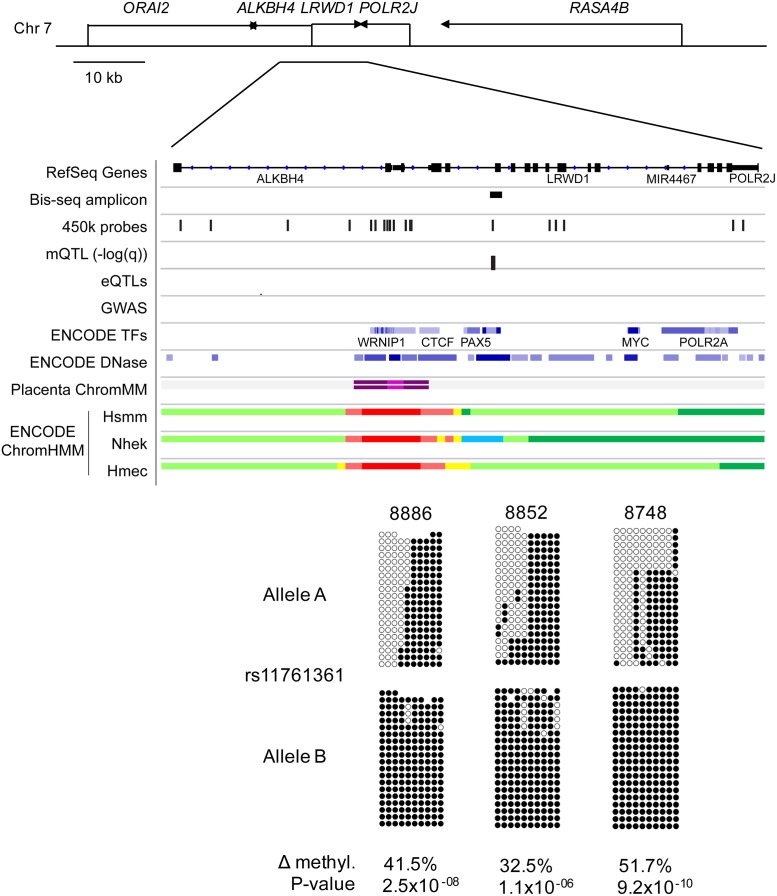
mQTL validation.Targeted bis-seq data showing Hap-ASM in LRWD1 region. The bis-seq amplicon covers 289 bp including the mQTL index CpG queried in Illumina 450K BeadChips arrays (cg25932869), as well as contiguous CpGs. Graphical representation from 3 representative heterozygous placenta samples with hap-ASM is shown. This region overlaps with the common SNP, rs11761361. Allele A and B are analyzed and represented separately. The SNP dictates methylation level with the alternate allele (allele B) being significantly hypermethylated compared to the reference allele (allele A), suggesting the presence of haplotype-dependent ASM in 19 out of 21 heterozygous samples. The low methylated allele is significantly biased toward allele A (p = 10−06, using binomial test) which ruled out imprinting. The hap-ASM overlaps with an insulator chromatin state (blue) in a NHEK cell line which suggests the presence of a dynamic regulatory element. For each heterozygous sample, Wilcoxon p value and methylation difference between alleles were calculated by bootstrapping (1,000 sampling of 20 reads per allele) and are indicated only for significant hap-ASM defined as the difference in percentage methylation >20%, >3 ASM CpGs, and p < 0.05. One representative random sample of each allele (20 reads per allele) is shown. mQTL, eQTL, and placenta chromatin states tracks are from our analyses. The GWAS SNPs track was downloaded from the NHGRI-EBI GWAS Catalog [1], TF ChIP-seq data, DNAse I hypersensitive sites and cell line chromatin states were downloaded from the ENCODE project [78]. ΔMeth (difference in the percentage of methylation between alleles in heterozygous samples) and Wilcoxon p-values are from bootstrapping.